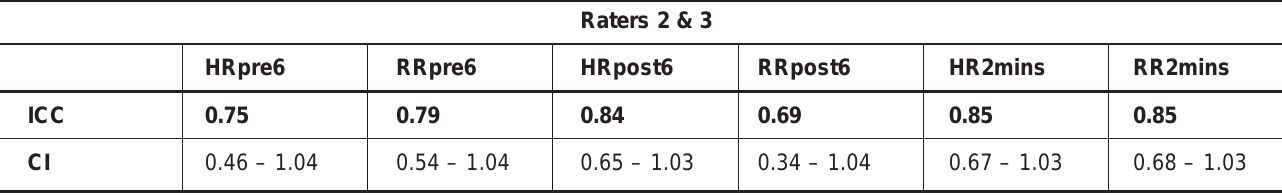
Table 4: ANOVA results for inter-observer correlation for 6-minute walk test (n =